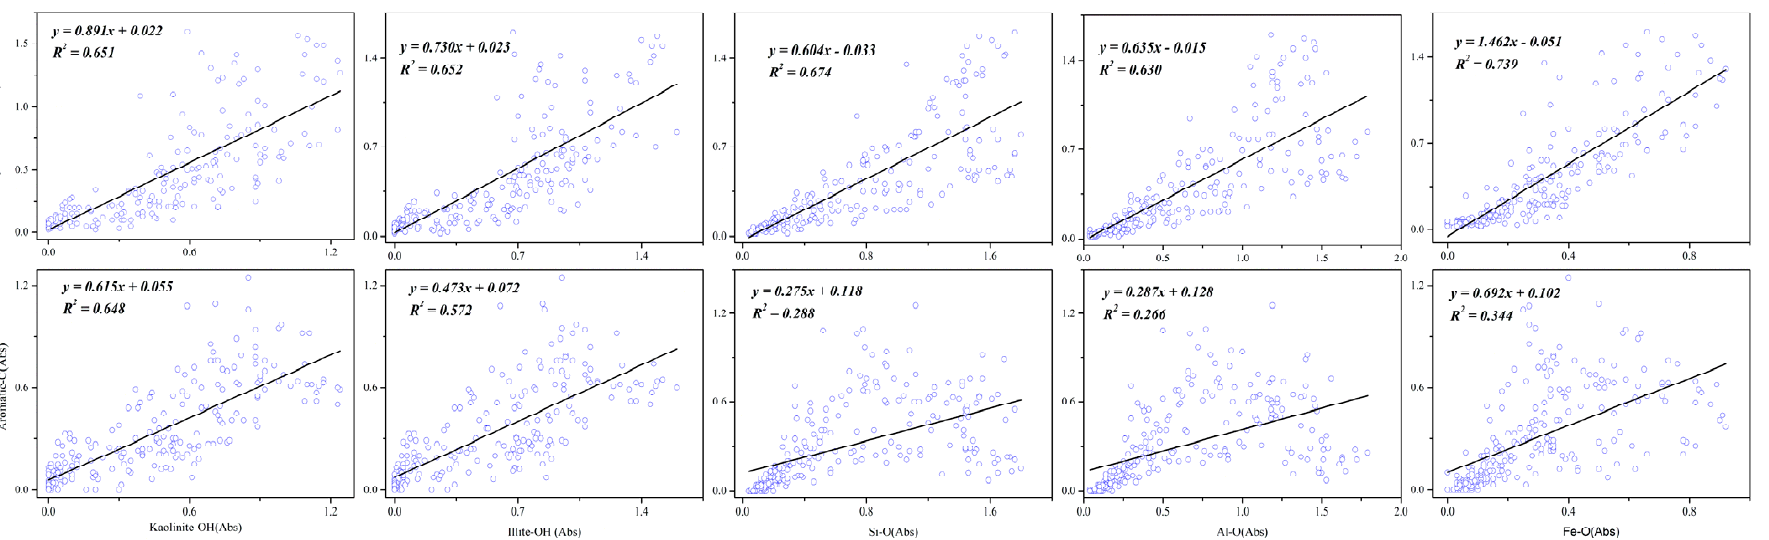
Figure 2. Correlation analysis between organic functional groups and minerals of the OM70 sam- ples. Data were extracted from Figure 1 using Omnic 9.0 (Thermo Fisher Scientific Inc., Waltham, MA, USA).